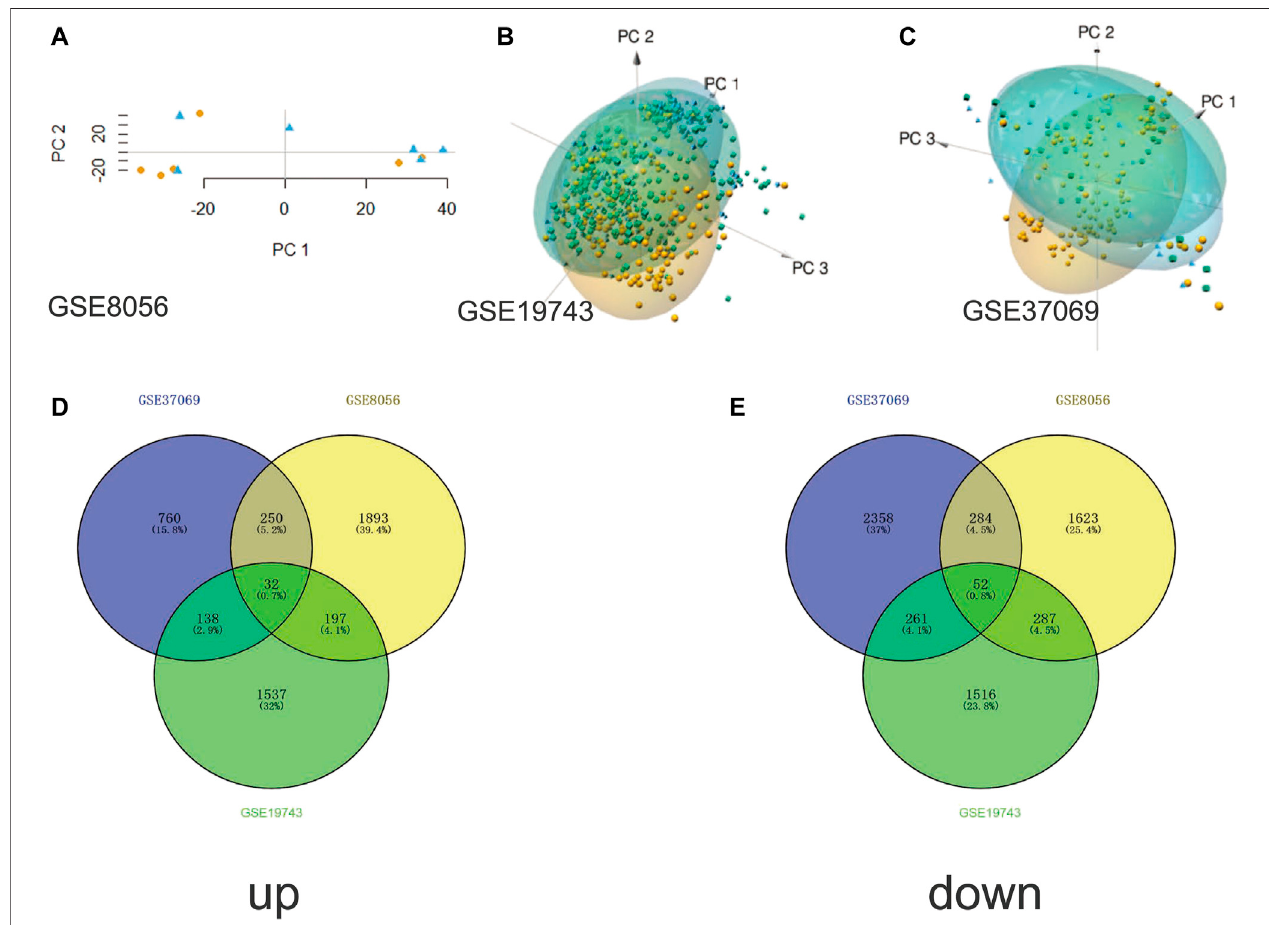
FIGURE1| Principal componentanalysisand Venn plotsofDEGs. (A) PCA resultsofGSE8056 dataset; (B) PCA results ofGSE19743 dataset; (C) PCA results of GSE37069 dataset; (D) Venn plot of upregulated DEGs; (E) Venn plot of downregulated DEGs.